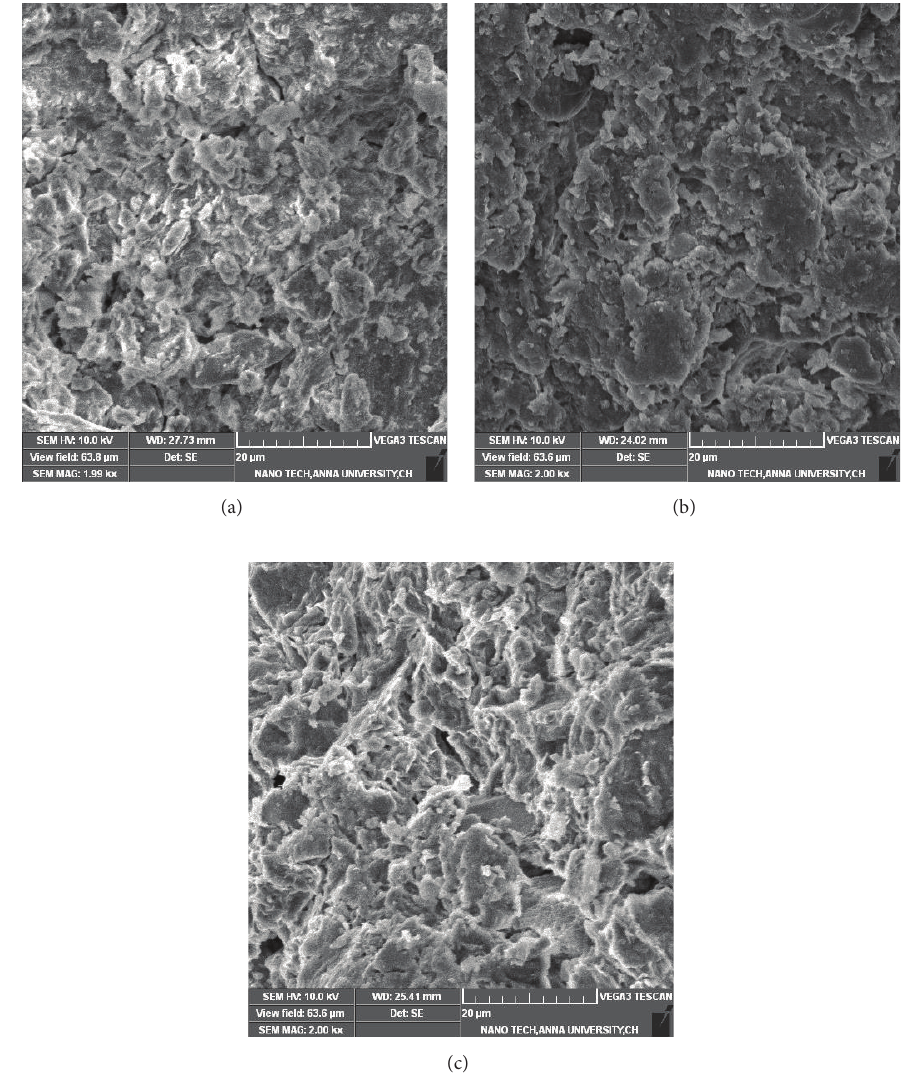
Figure 10: Microstructure of soil stabilized with (a) 3% lime + 0.25% PG; (b) 5.5% lime + 0.5% PG; (c) 7% lime + 1% PG.